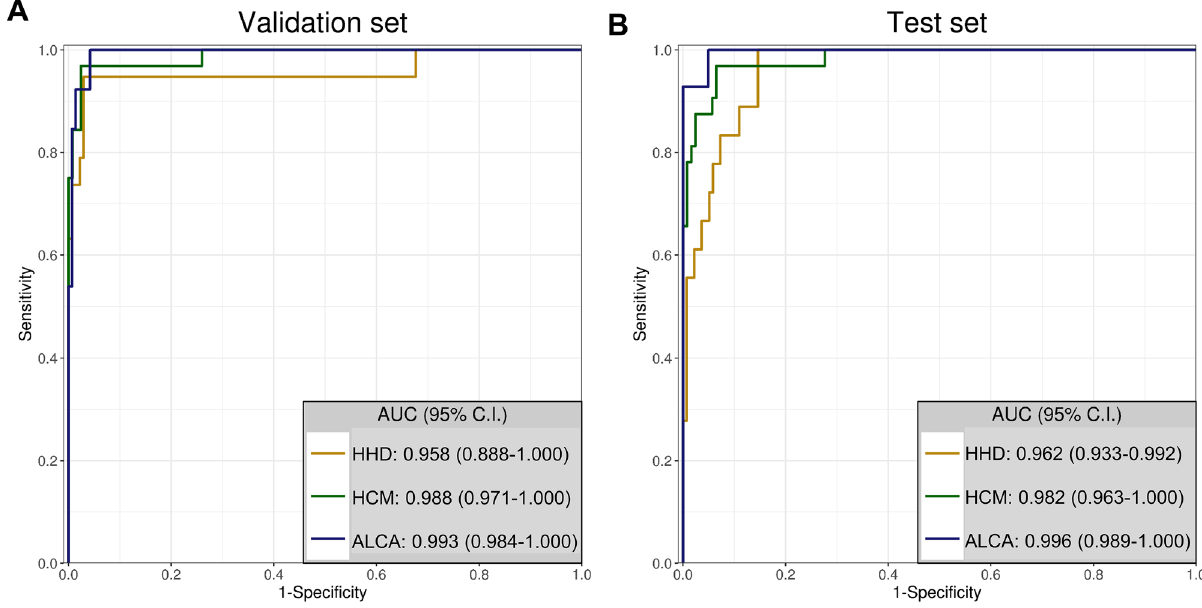
Figure 2. ROC curve analysis of the deep learning algorithm for the differential diagnosis of LVH. The diagnostic accuracy of the deep learning algorithm was calculated using the AUC for the validation ( A ), and test sets ( B ). This figure was generated using R software v.4.1.1, R Core Team (2021). R: A language and environment for statistical computing. R Foundation for Statistical Computing, Vienna, Austria. URL http:// www.r- proje